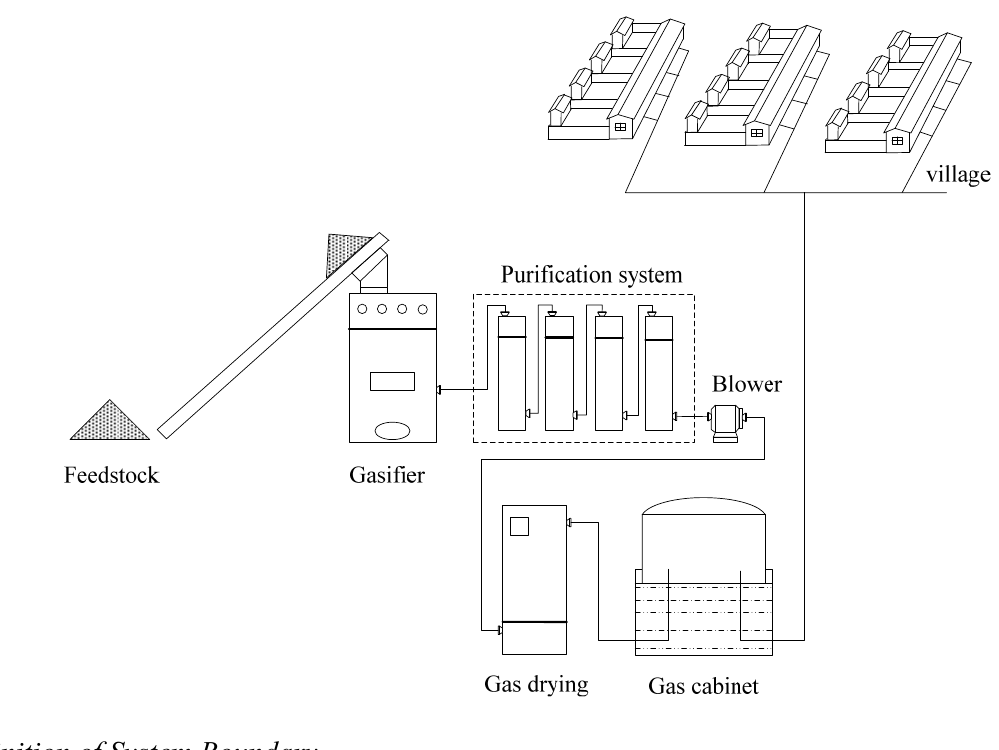
Figure 1. The flow chart of village-level biomass gasification